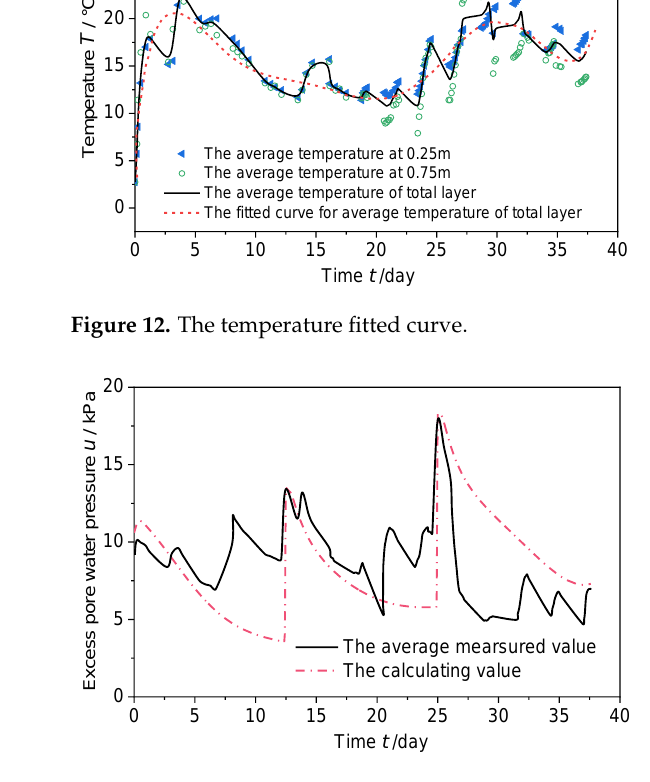
Figure 13. Comparison of excess pore water pressure in solar heating group.